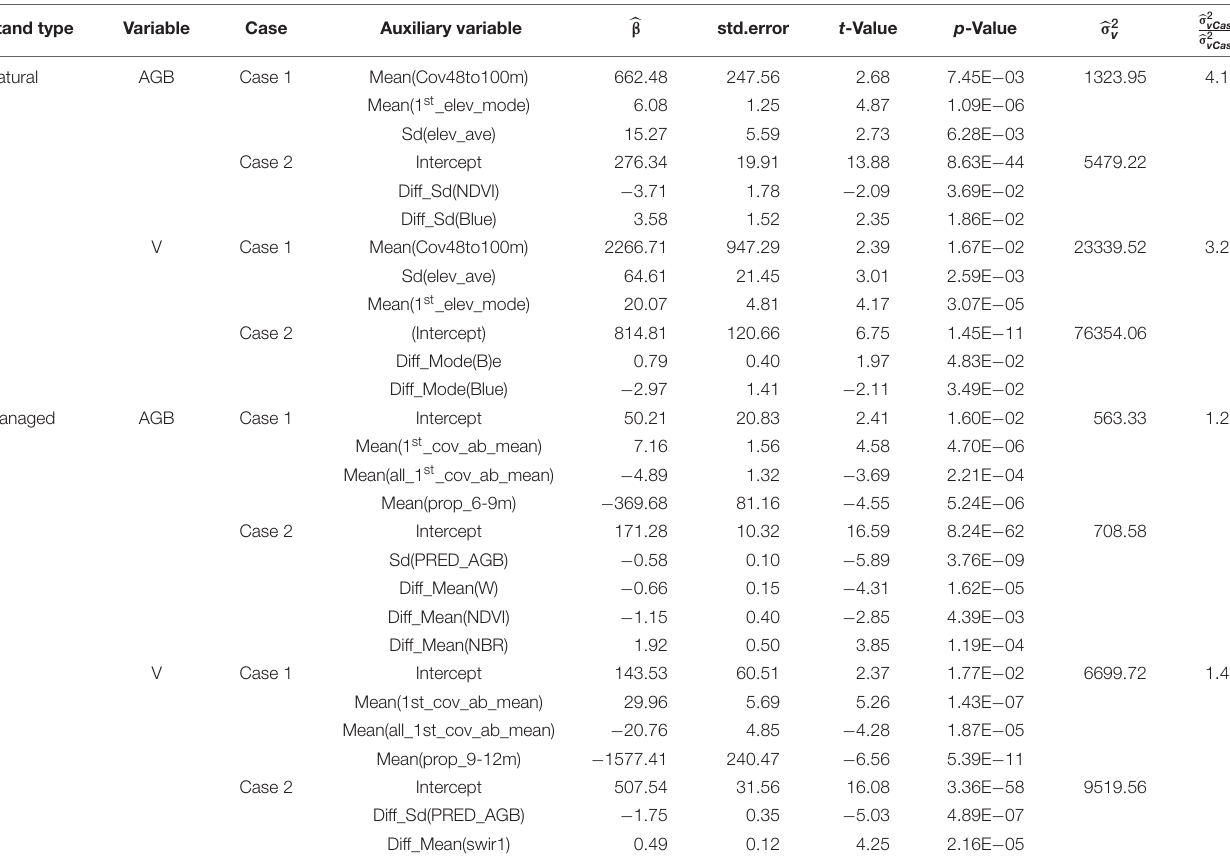
TABLE 2 | Summary of selected models for Case 1 and Case 2 for above-ground biomass, AGB (Mg ha − 1 ), and volume, V (m 3 ha − 1 ). Stand